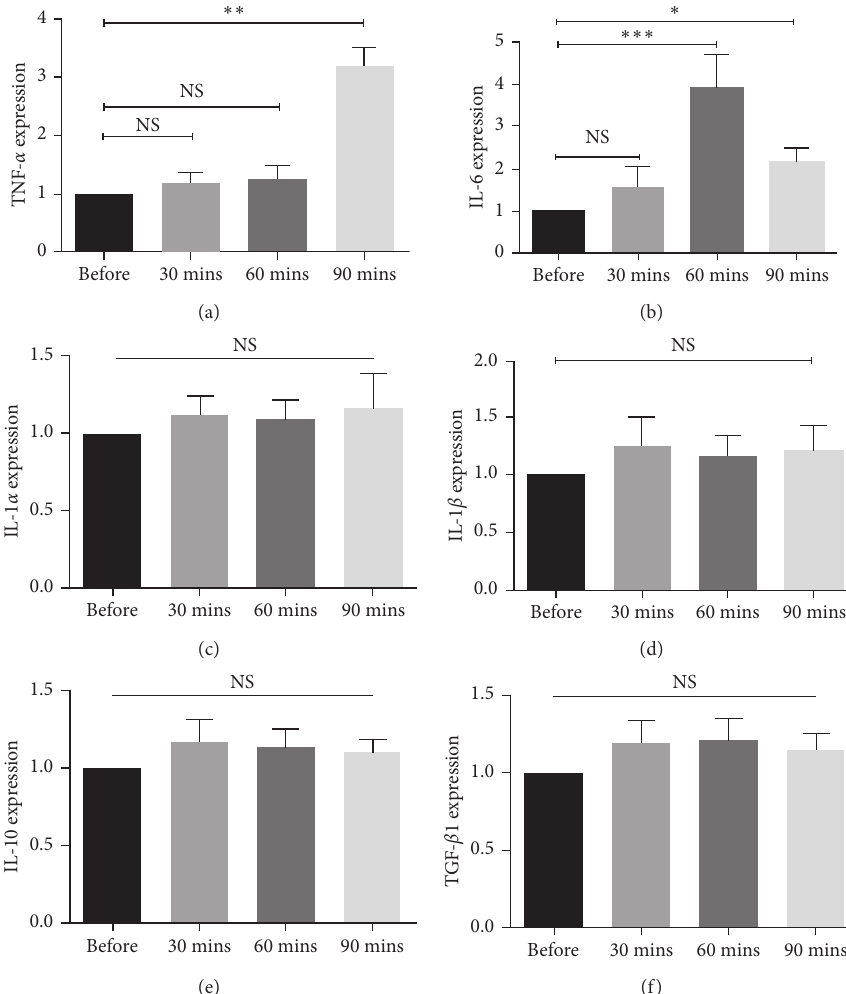
Figure 1: The effect of liver regeneration on the expression levels of proinflammatory and anti-inflammatory cytokines in HCC patients. The expressions of (a) IL-6, (b) TNF- α , (c) IL-1 α , (d) IL-1 β , (e) IL-10, and (f) TGF- β 1 were determined by real-time PCR assay before and after LR. All data are shown as mean ± SEM. The depicted results are representative of 15 independent experiments. NS indicates that the differences in the expression levels are not statistically significant. Asterisks indicate that the differences in the expression levels are statistically significant. ∗ P < 0 . 05, ∗∗ P < 0 . 01, and ∗∗∗ P < 0 . 001. ∗∗∗∗